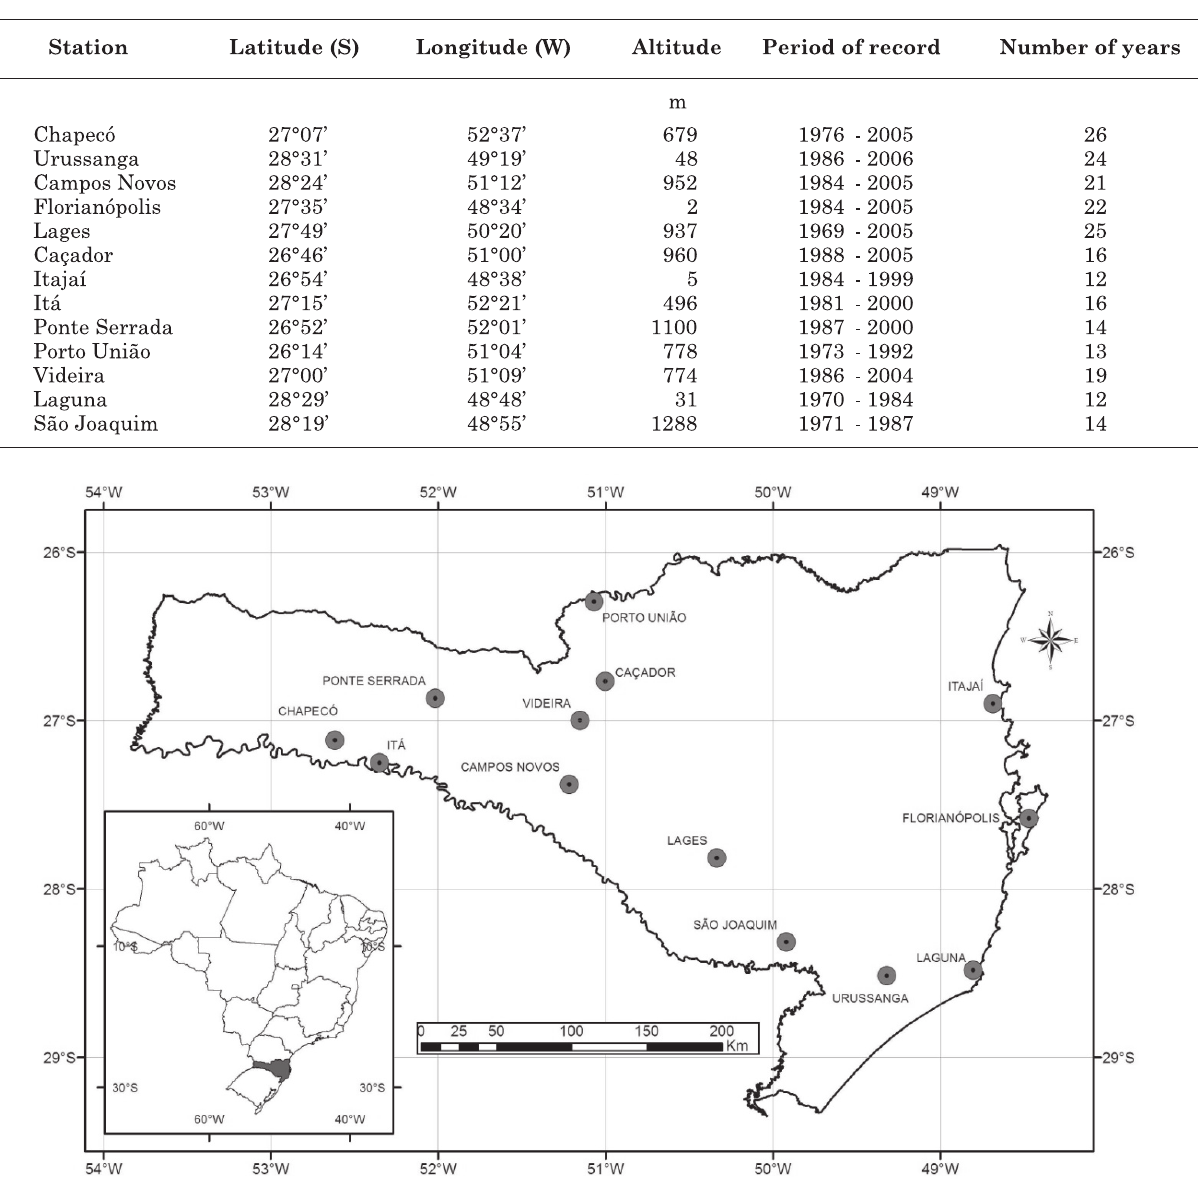
Figure 1. Location of rain gauge stations in Santa Catarina,